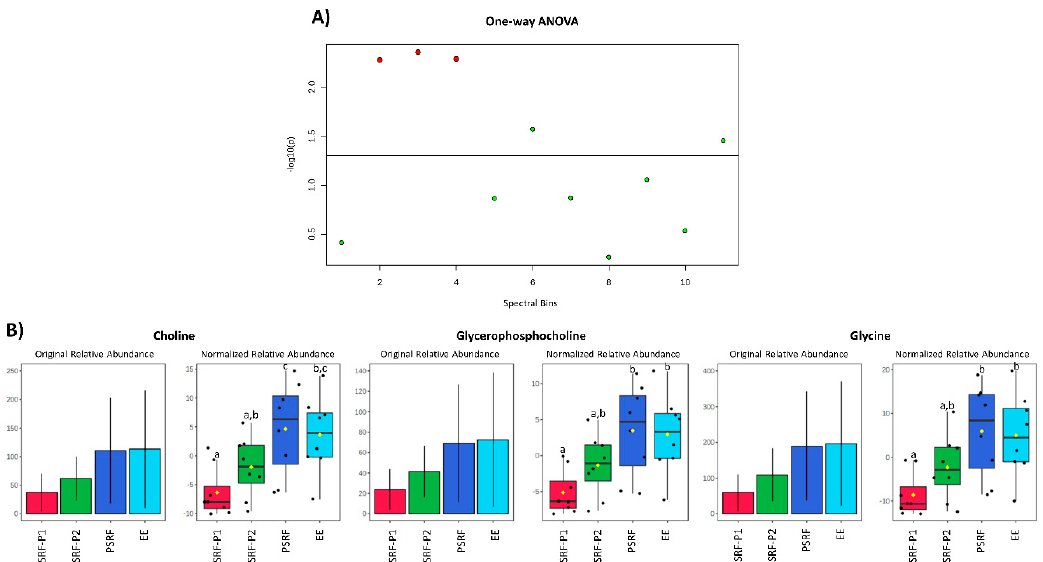
Figure 3. Comparison of the relative areas under each metabolite peak from the pig seminal plasma (SP) of di ff erent ejaculate-portions. ( A ) Graphical representation of one-way ANOVA, generated using MetaboAnalyst [48]. Red points represent metabolites whose relative values di ff er ( p < 0.05) between at least two ejaculate-portions. Green points represent metabolites whose relative values do not di ff er ( p > 0.05) between at least two ejaculate-portions. ( B ) Box plot representations of the original and the normalized relative abundance for the metabolites presenting di ff erences between ejaculate-portions (first 10 mL from the sperm-rich fraction [SRF-P1], the rest of the sperm rich fraction [SRF-P2], the post-sperm-rich fraction [PSRF] and the entire ejaculate [EE]). Di ff erent superscripts (a–c) indicate di ff erences ( p < 0.05) between ejaculate-portions.